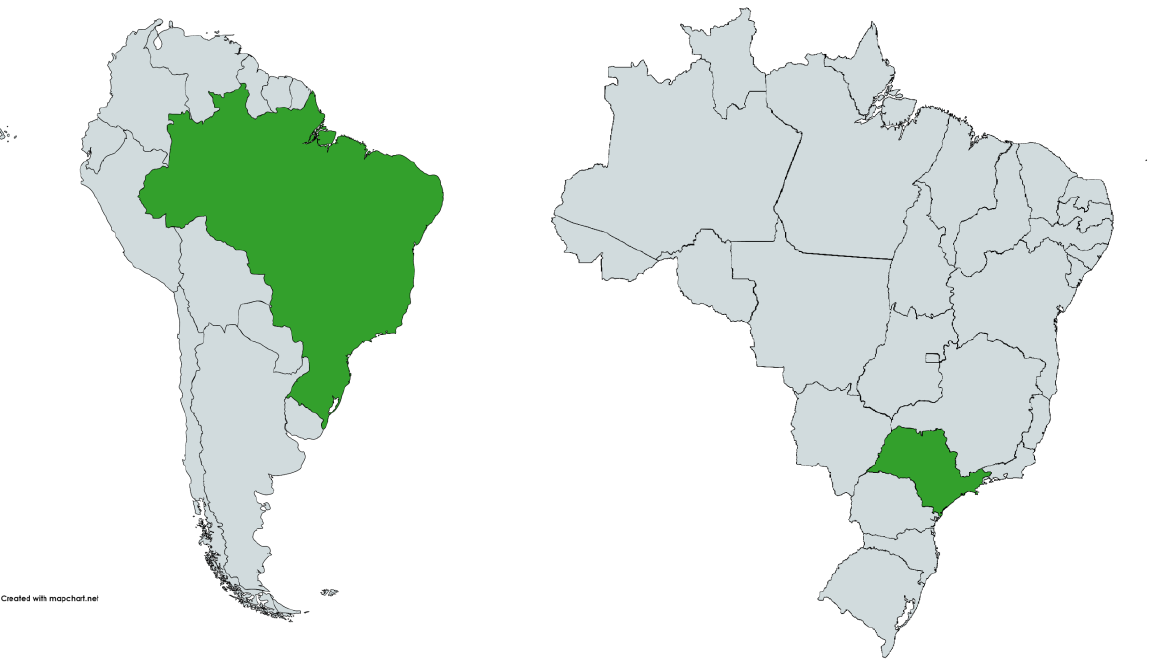
Figure 2. S ã o Paulo